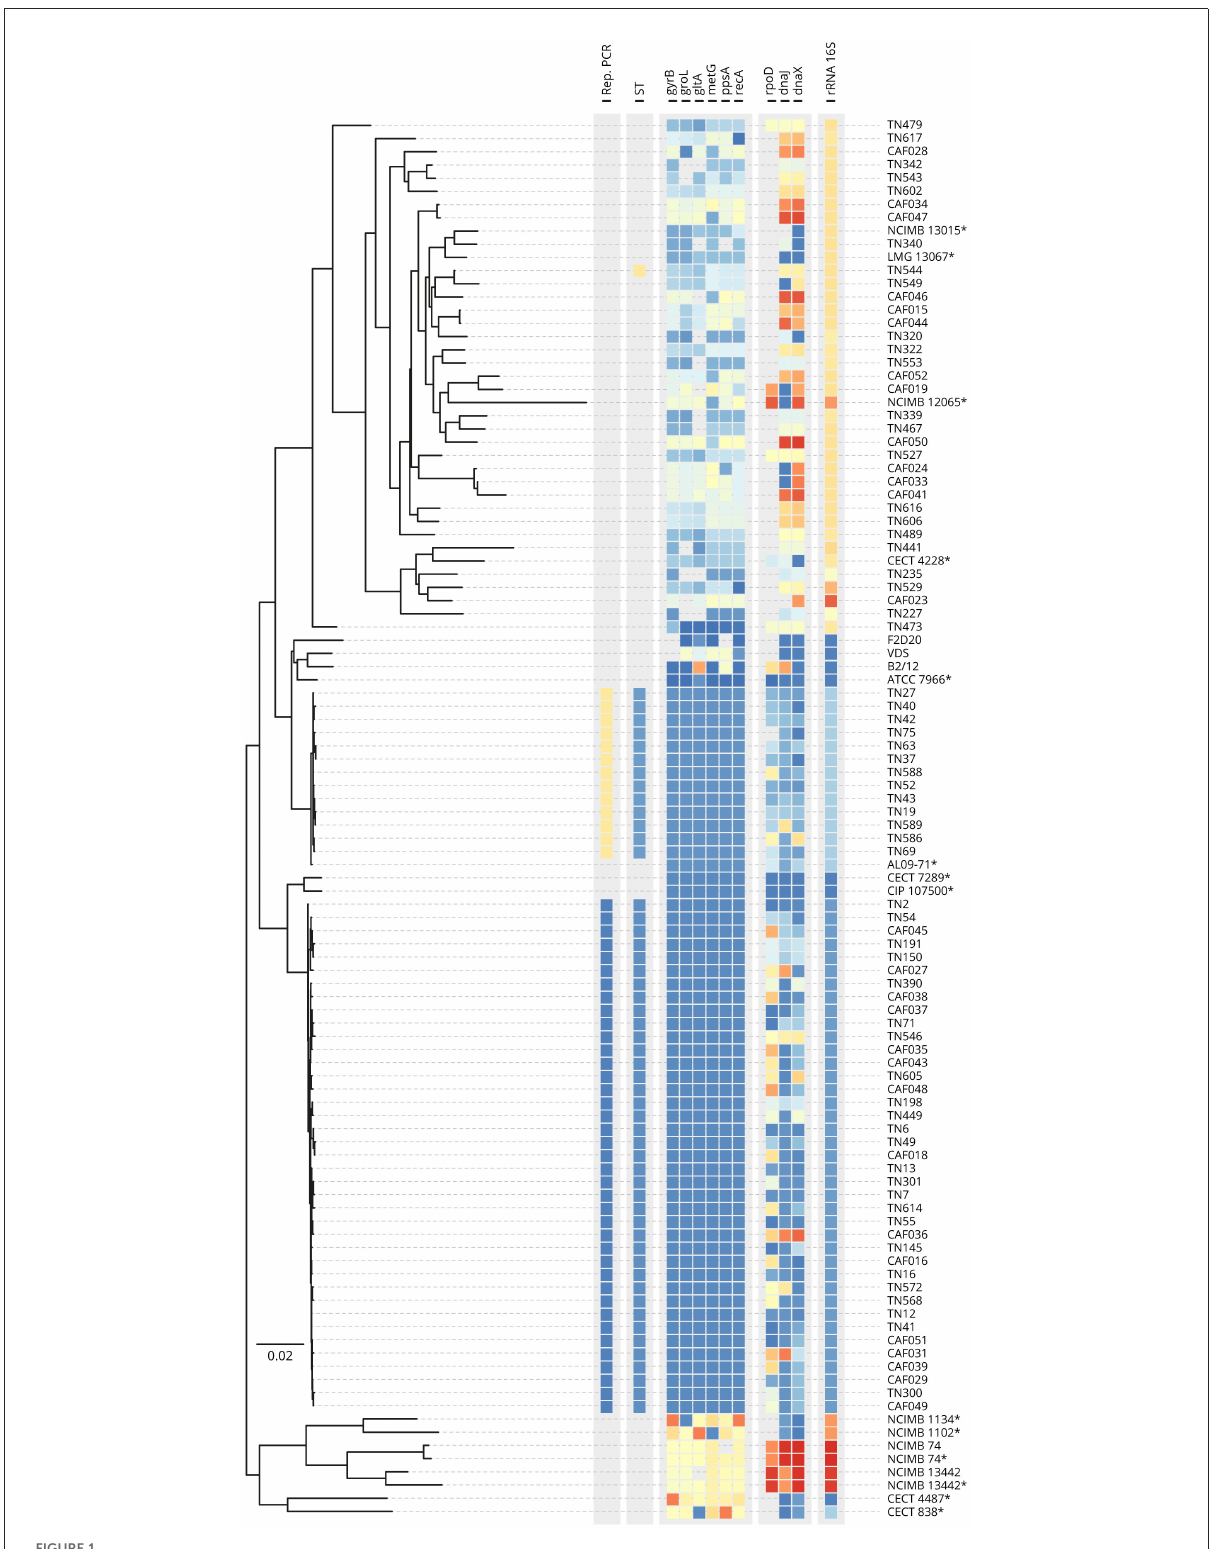
FIGURE1 Multilocus phylogenetic analysis by sequence comparison of concatenated housekeeping genes at 10 loci for 87 representative field isolates of Aeromonas from striped catfish, five reference isolates, and 12 type strains. rep-PCR type, sequence type (ST), and alleles derived from ngsMLST analysis of 10 genes including 16S rRNA are color coded. *Gene sequences (when available) were retrieved from the genome assembly at